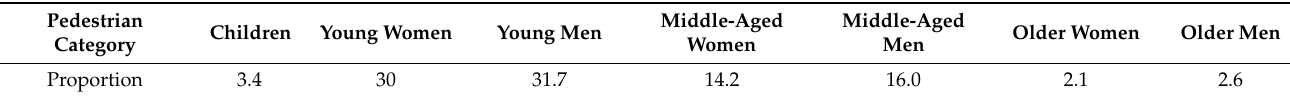
Table 6. Proportion of people (%).